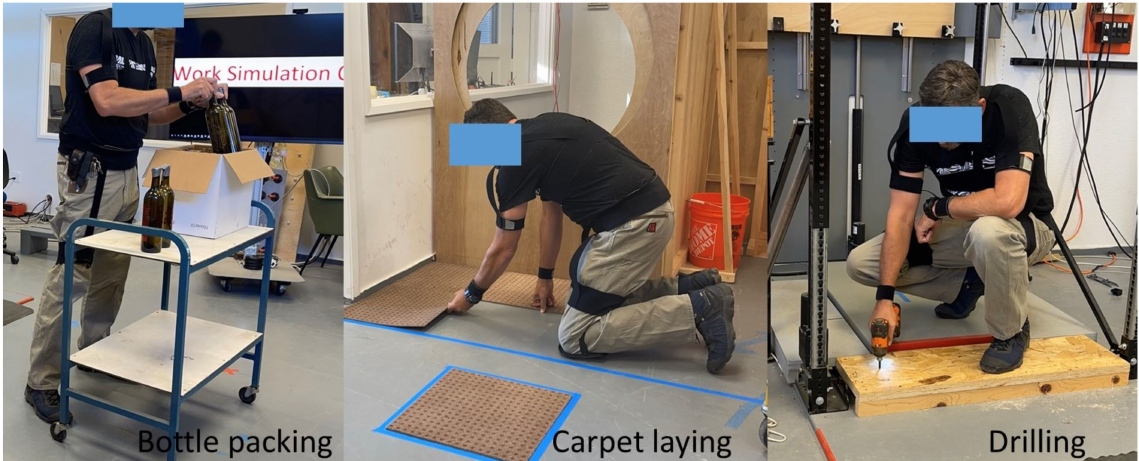
Figure 2. Manual material handling tasks: bottle packing, carpet laying, and